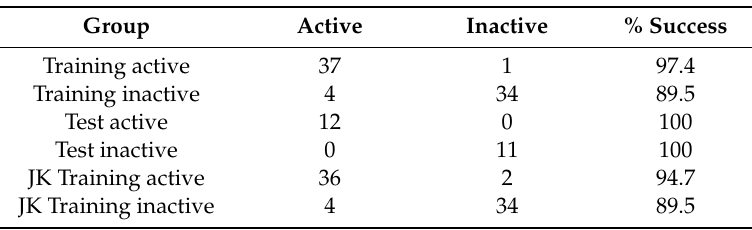
Table 4. Classification matrix for